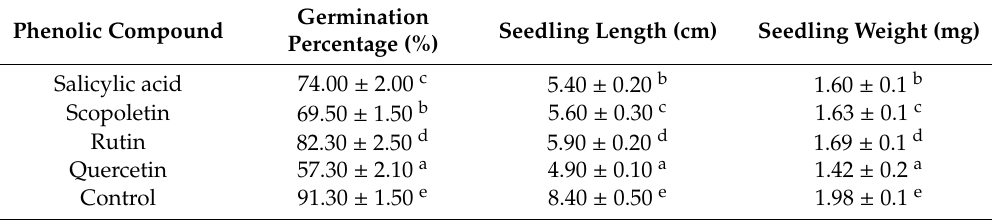
Table 5. Autotoxic e ff ect of HPLC-identified compounds on alfalfa seed germination and seedling